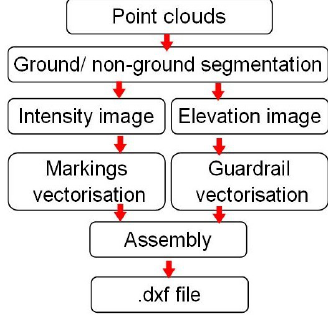
Figure 5. Main points of the proposed guardrail and marking road extraction and vectorization.